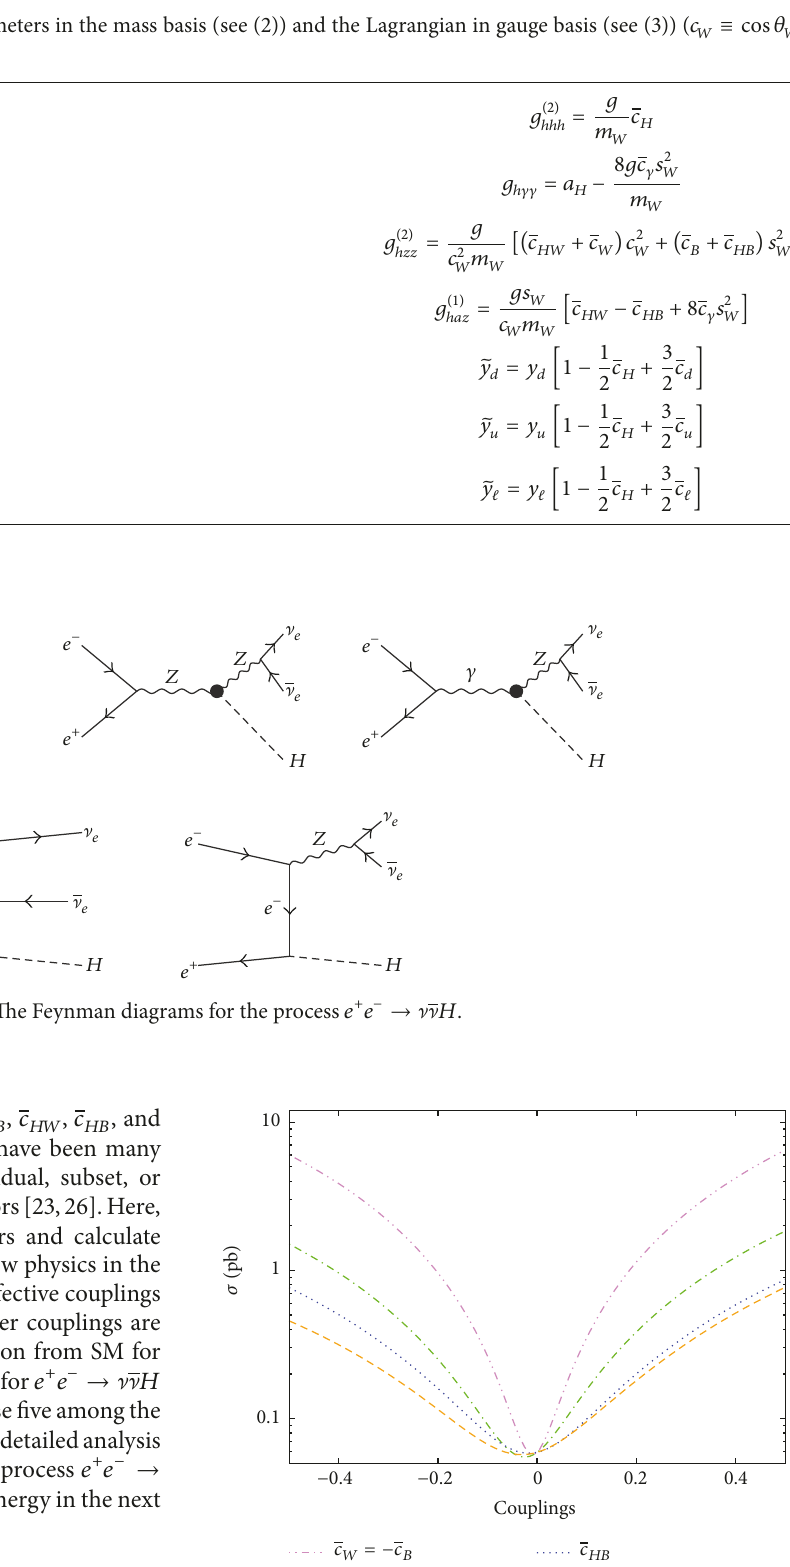
𝑒 + 𝑒 − → ]] 𝐻 process at